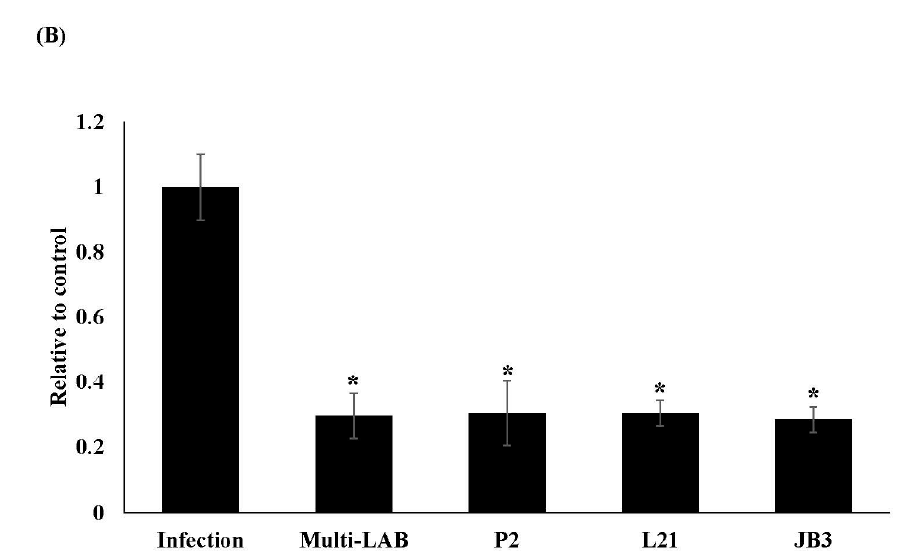
Figure 1. E ff ects of LAB strains on the expression levels of 16s rRNA ( A ) and vacA gene ( B ) of H. pylori in stomachs of mice. * Means significantly di ff erent from infection group, p < 0.05. Nutrients 2020 , 12 , x FOR PEER REVIEW